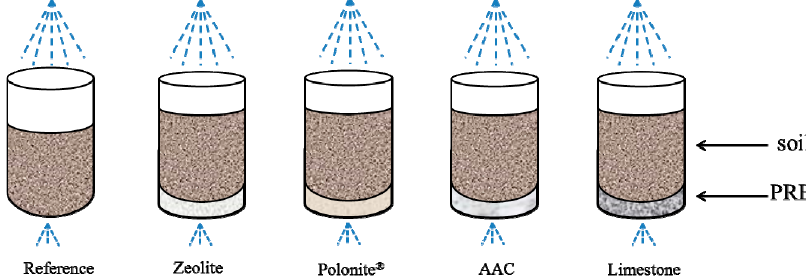
Figure 2. Setup of leaching experiment with examined soil (reference) and four different reactive materials as a phosphorus permeable reactive barriers